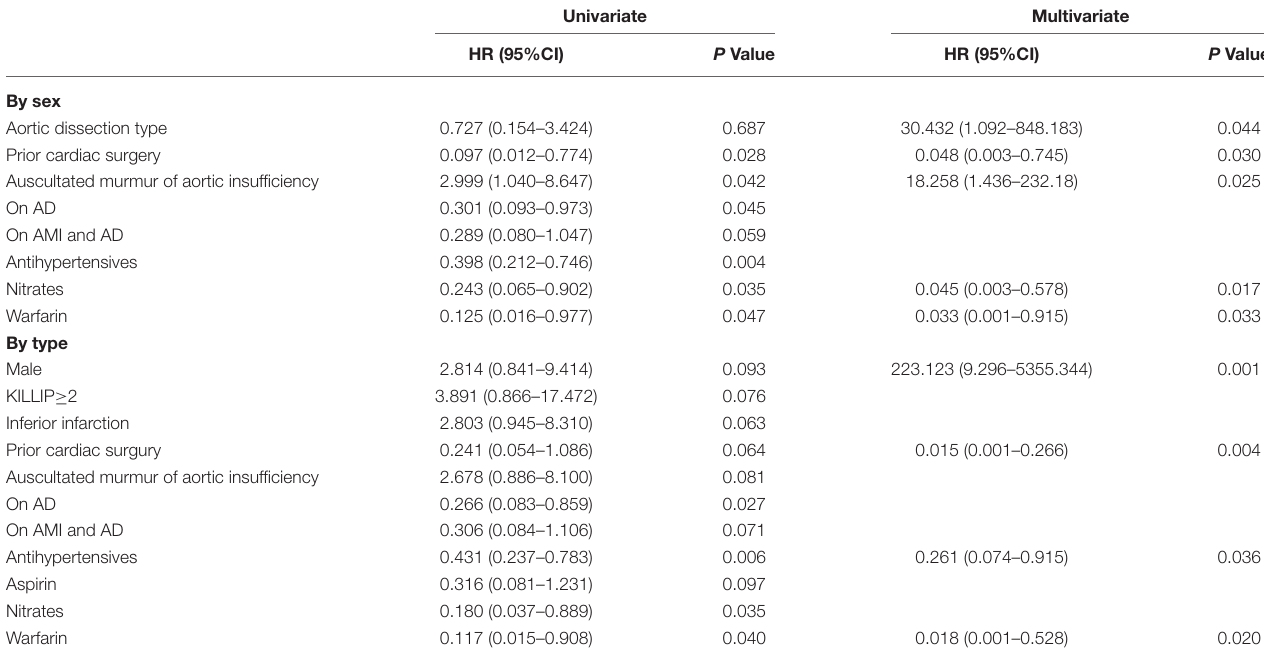
TABLE 5 | Cox regression analysis for death over the follow-up.